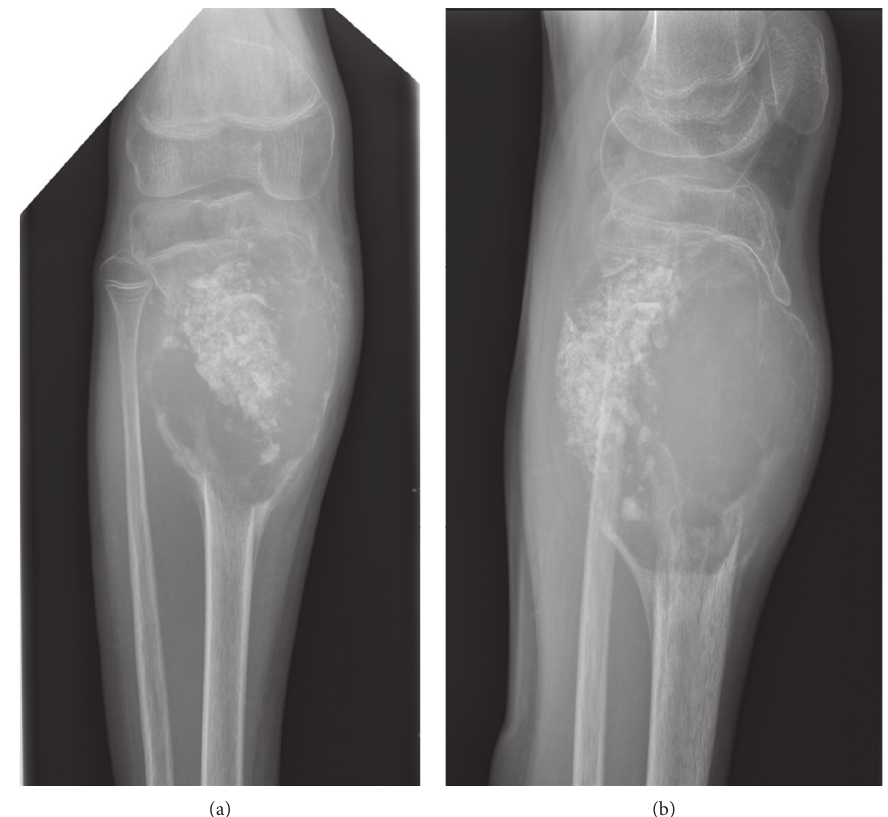
Figure 1: Anteroposterior (a) and lateral (b) plain radiographs of the right lower leg demonstrating a recurrent ABC after initial detailed curettage and allogenic bone grafting.